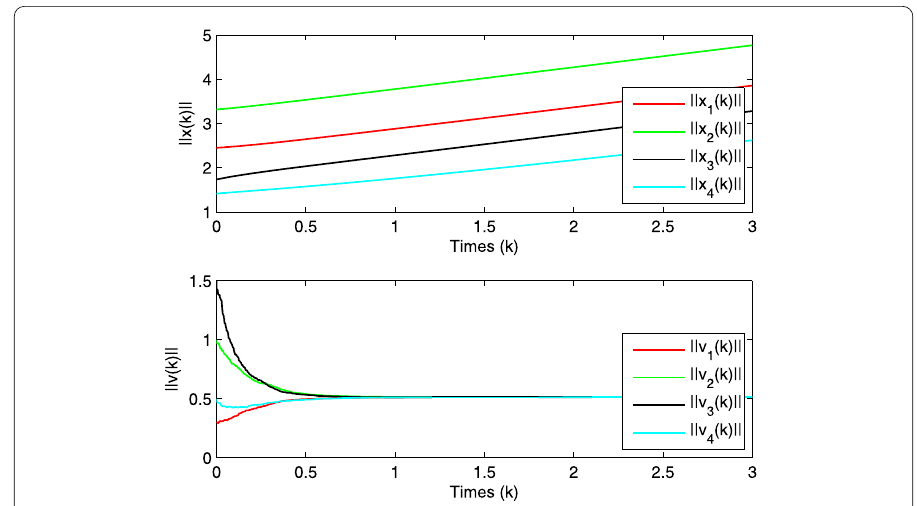
Figure 3 The norms of position and velocity trajectories with α = 1 in Case 1